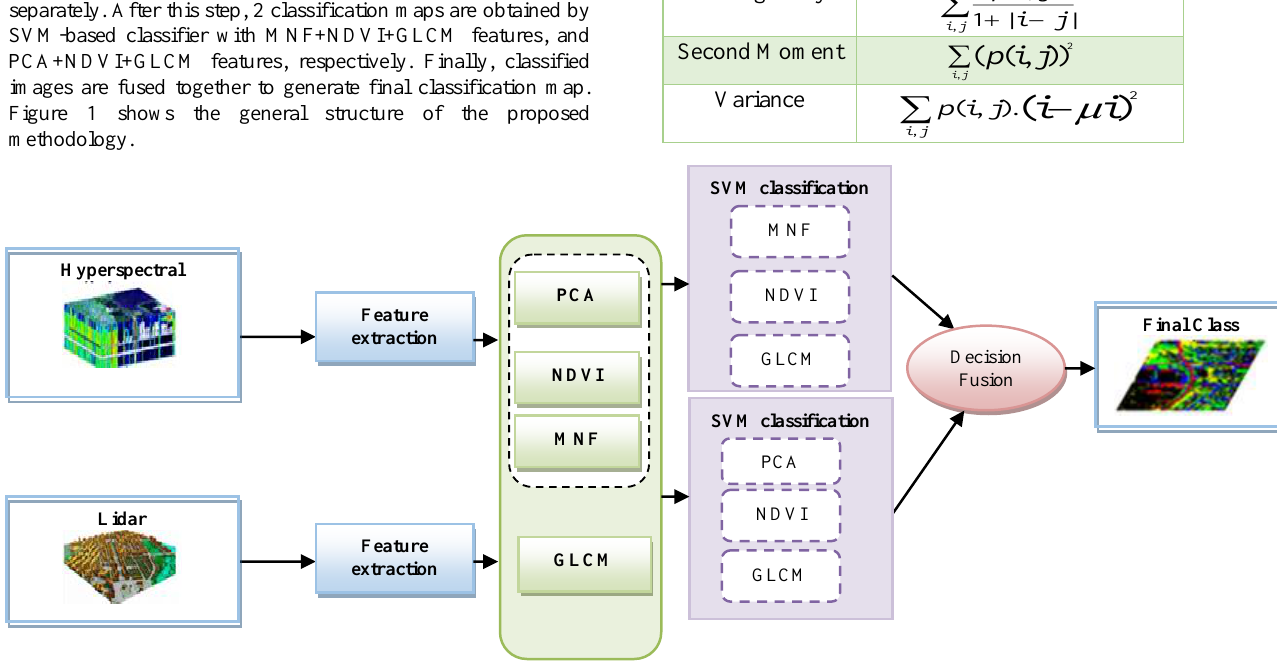
Figure 1. Flowchart of proposed method for fusion of hyperspectral and Lidar